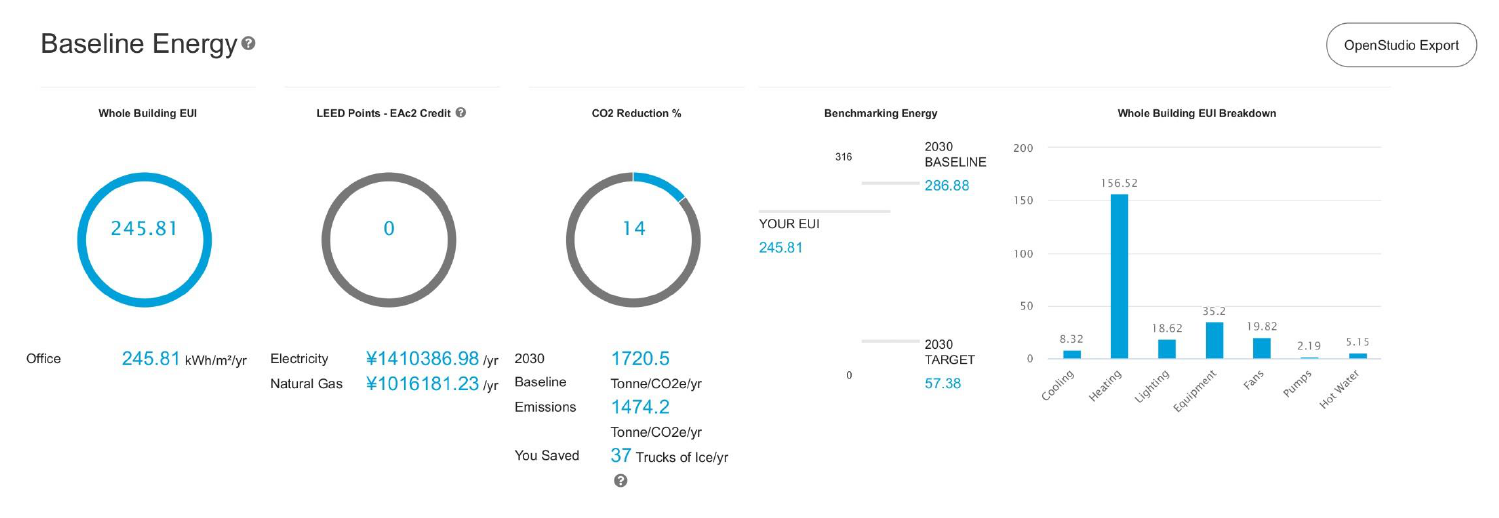
Figure A13. Zone 4- A Xi’an, Shaanxi (pre-COVID-19 scenario). Figure A13. Zone 4-A Xi’an, Shaanxi (pre-COVID-19 scenario).